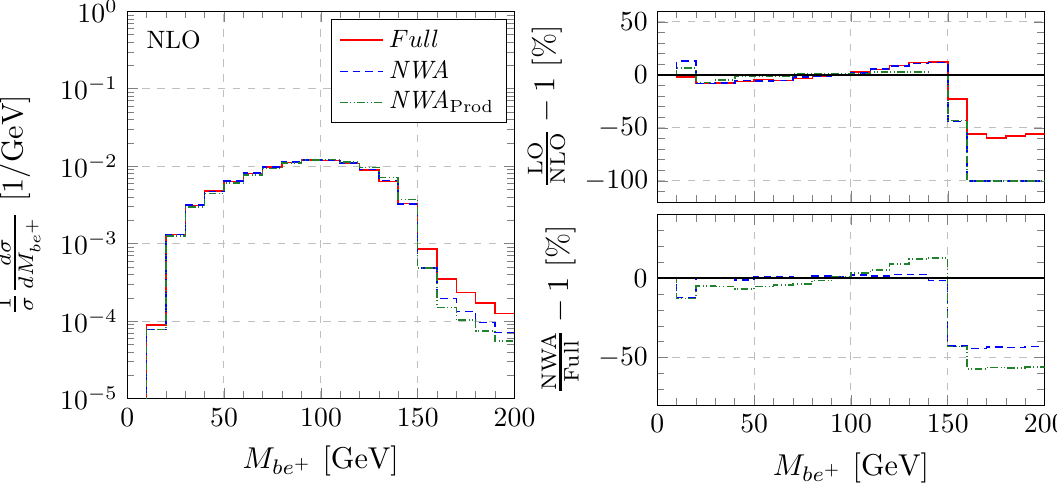
(cid:22) bj + + (cid:23) e (cid:22) (cid:0) (cid:22) (cid:23) (cid:22) b